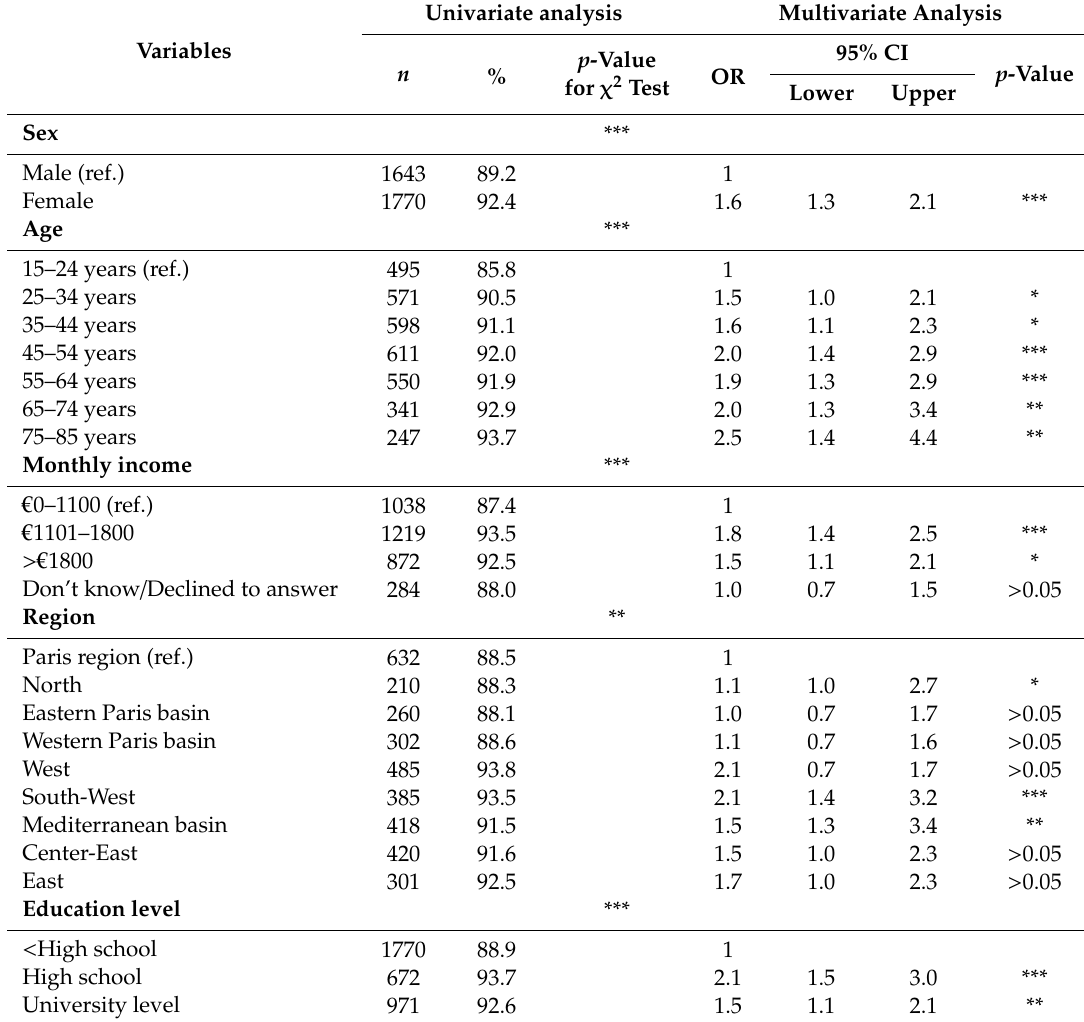
Table 3. Sociodemographic factors associated with the perception of diet as an important factor in cancer development in 2015 ( n =